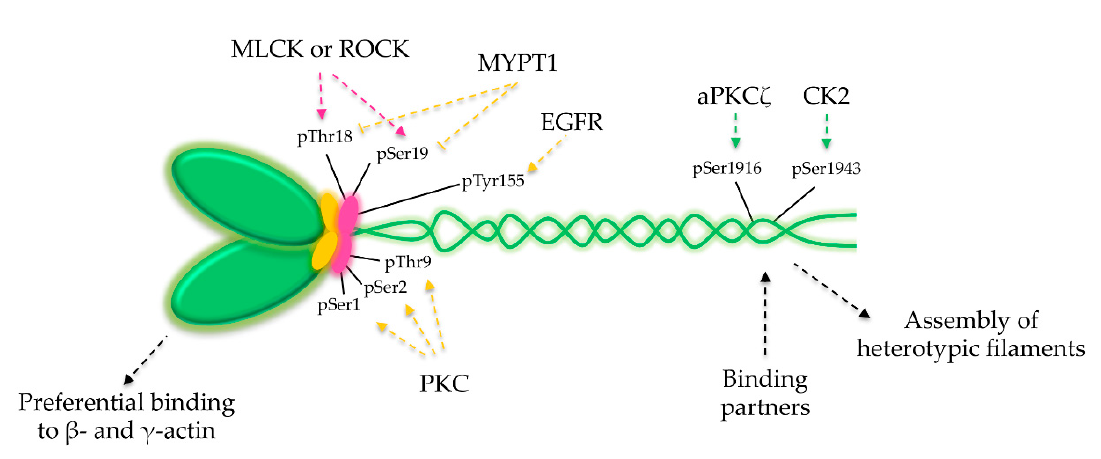
Figure 5. Multiple mechanisms regulate NM2A activity and subcellular localization. NM2A activation (pink arrows) and inactivation (yellow arrows) are mainly regulated through RLC phosphorylation or dephosphorylation on Ser, Thr and Tyr residues. Events occurring at the NM2A tail, such as phosphorylations (green arrows), interaction with binding partners and co-polymerization of heterotypic filaments, control the assembly and disassembly of NM2 filaments. Regulation through the head domain is determined by the differential binding of NMHC2 to distinct actin isoforms.